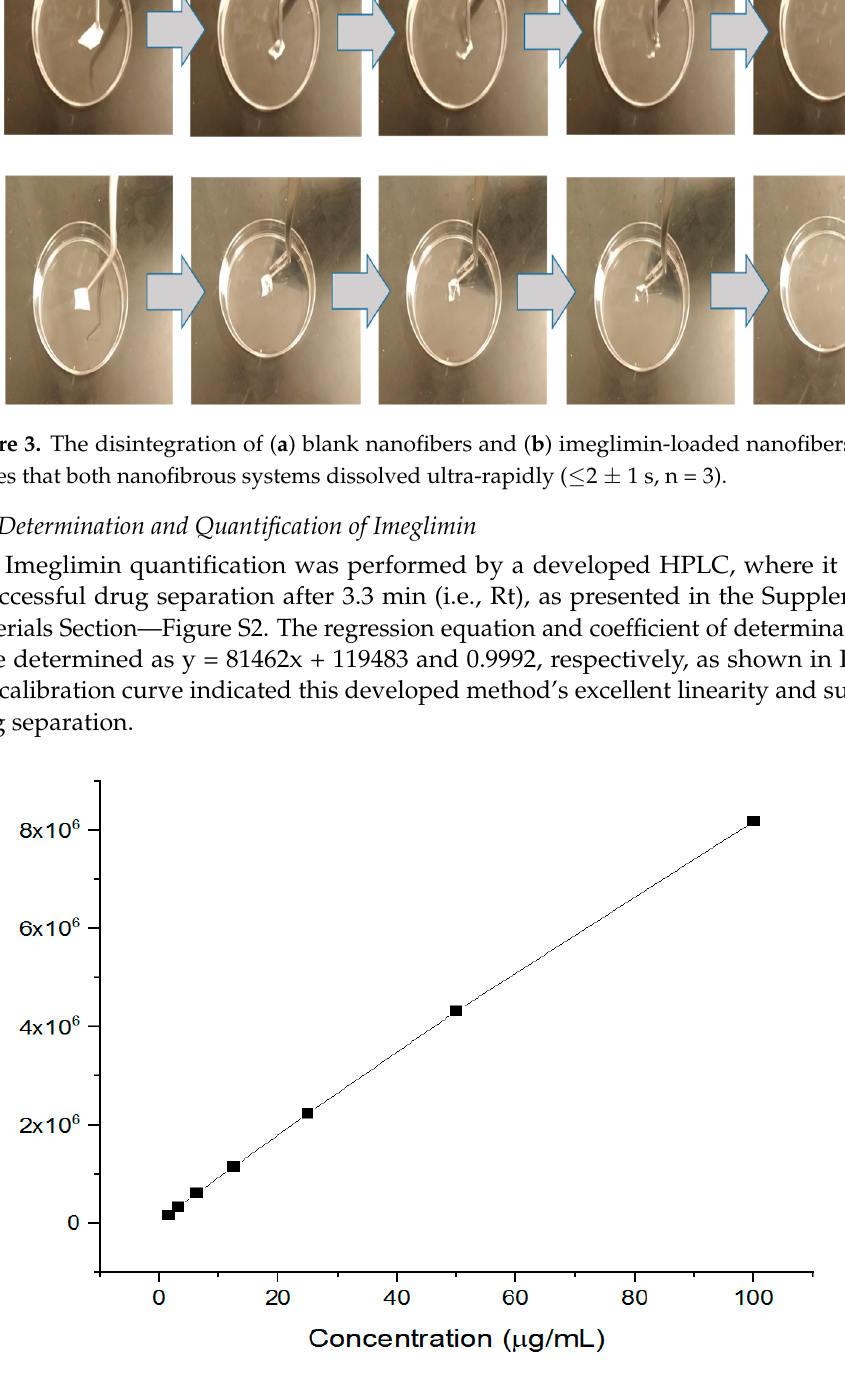
Figure 4. The developed HPLC calibration curves of imeglimin show its excellent linearity (R 2 = 0.9992).